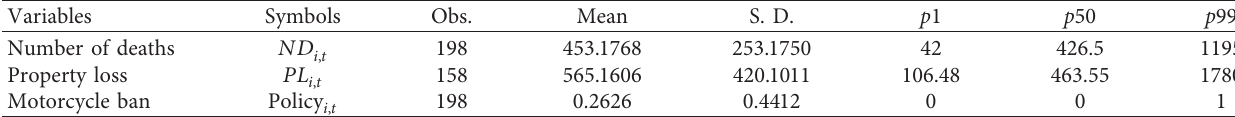
Table 3: The statistics of the main